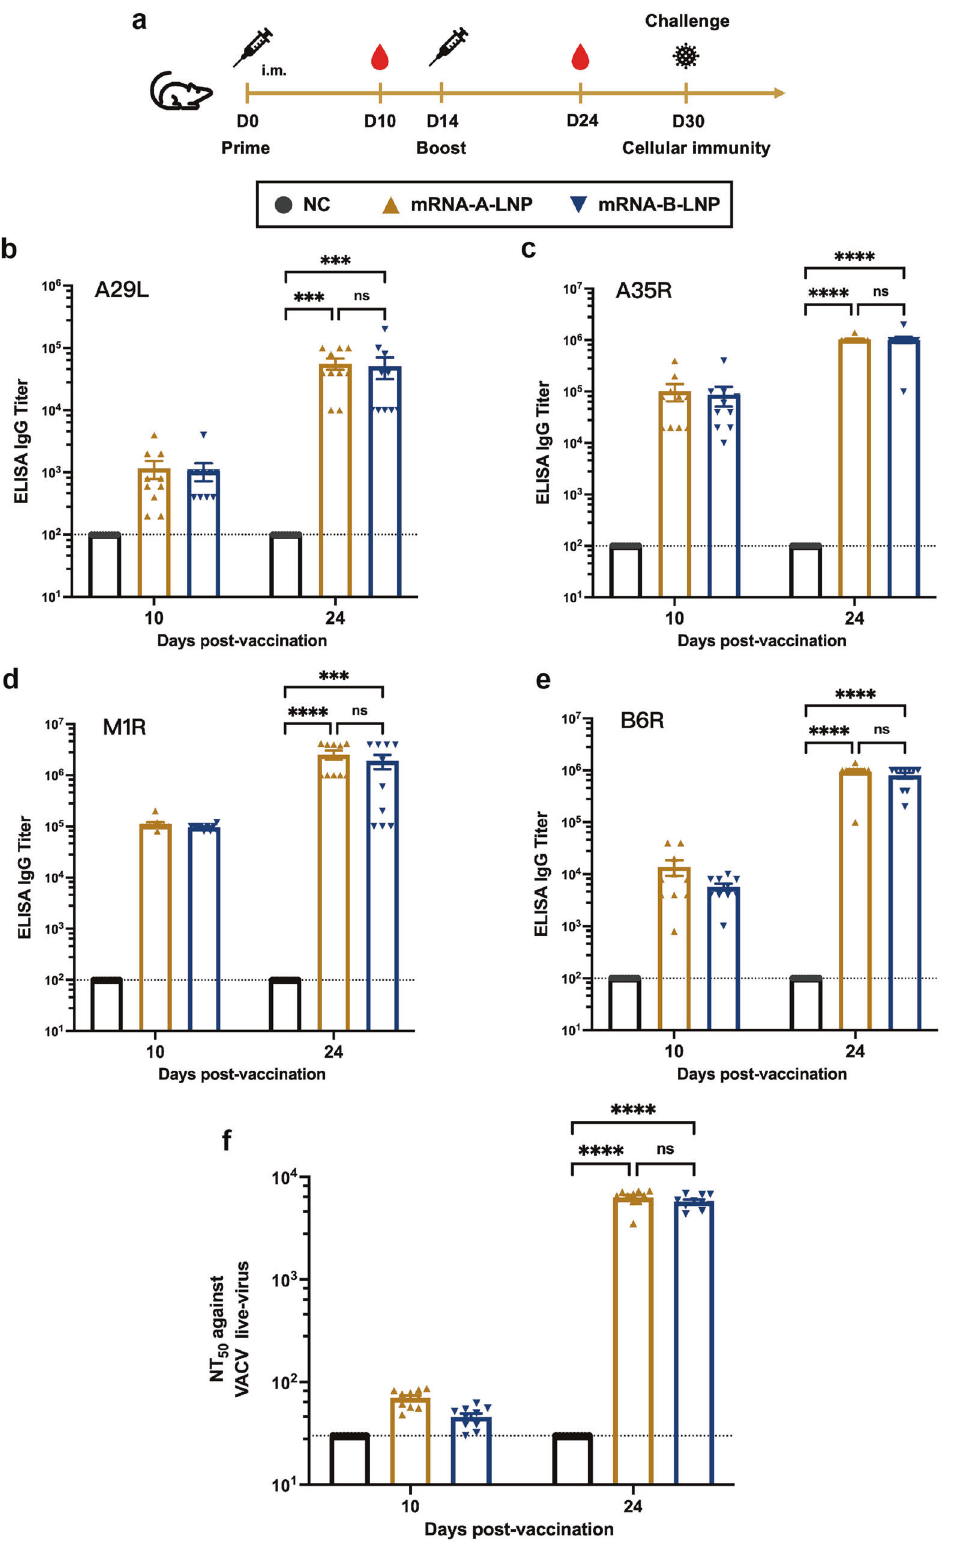
The binding antibody responses against MPXV antigens (A29L, A35R, M1R and B6R) were assessed by enzyme-linked immuno- sorbent assay (ELISA). Antibodies against all four target antigens were detected in all vaccinated mice and increased signi fi